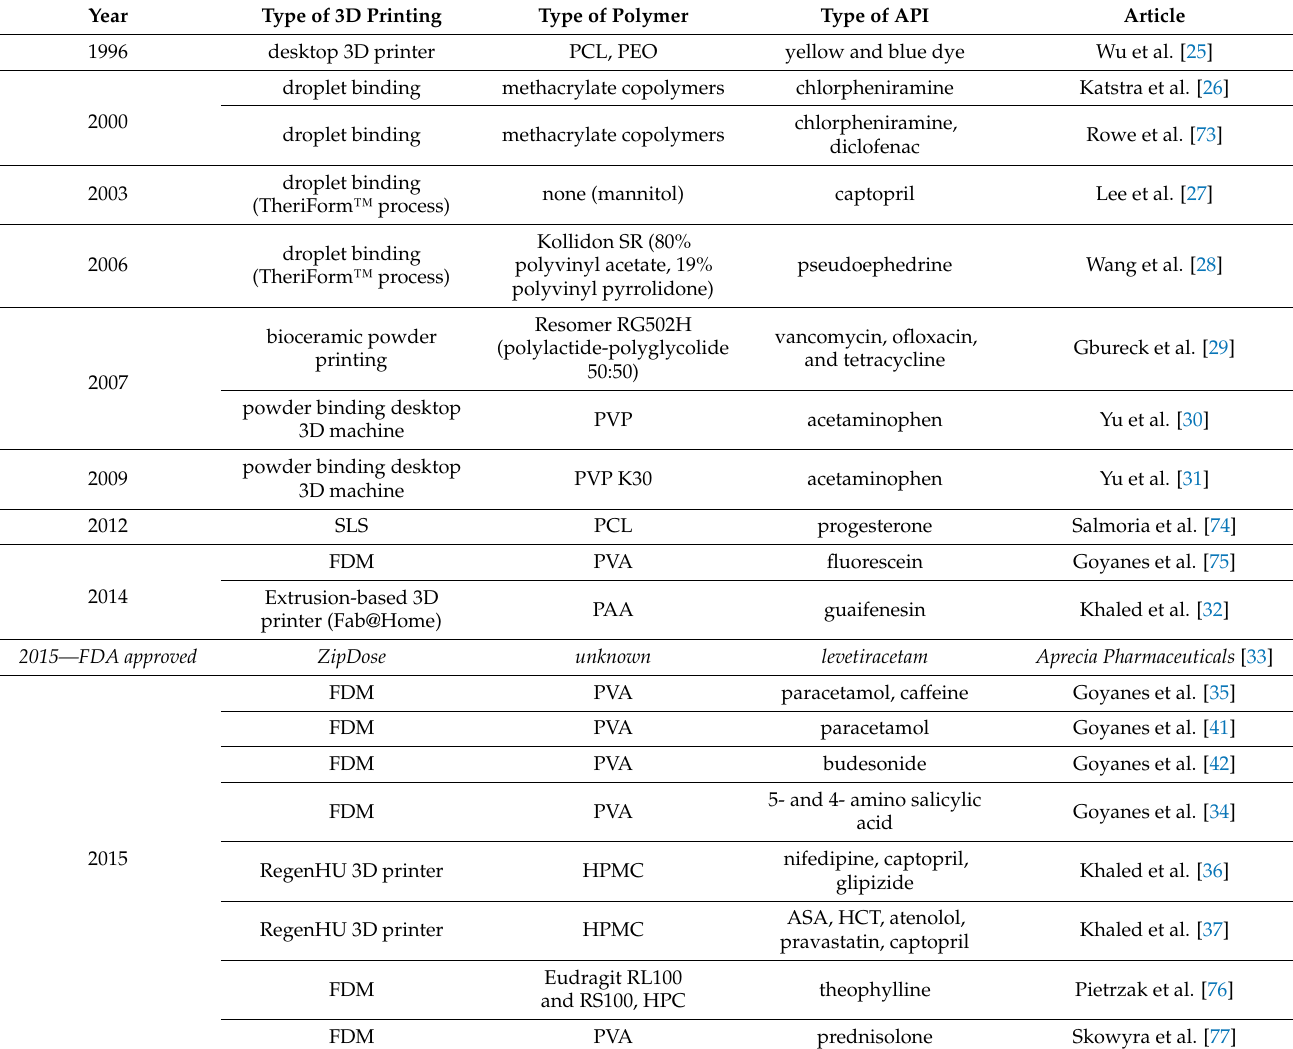
Table 1. The grouping of the manufactured tablets based on the publication year and then in alphabetical order between 1996 and